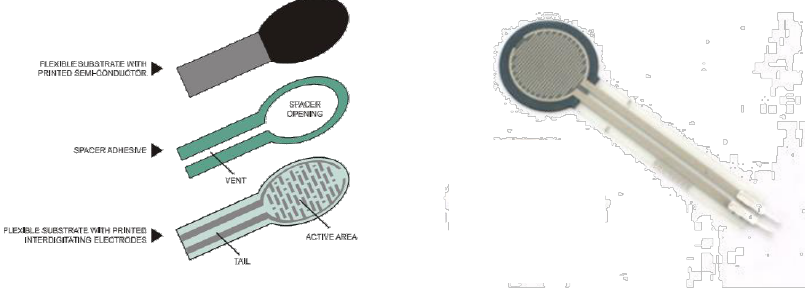
Figure 3 . FSR-Interlink402 sensors ( right ) and its detailed configuration ( left ).